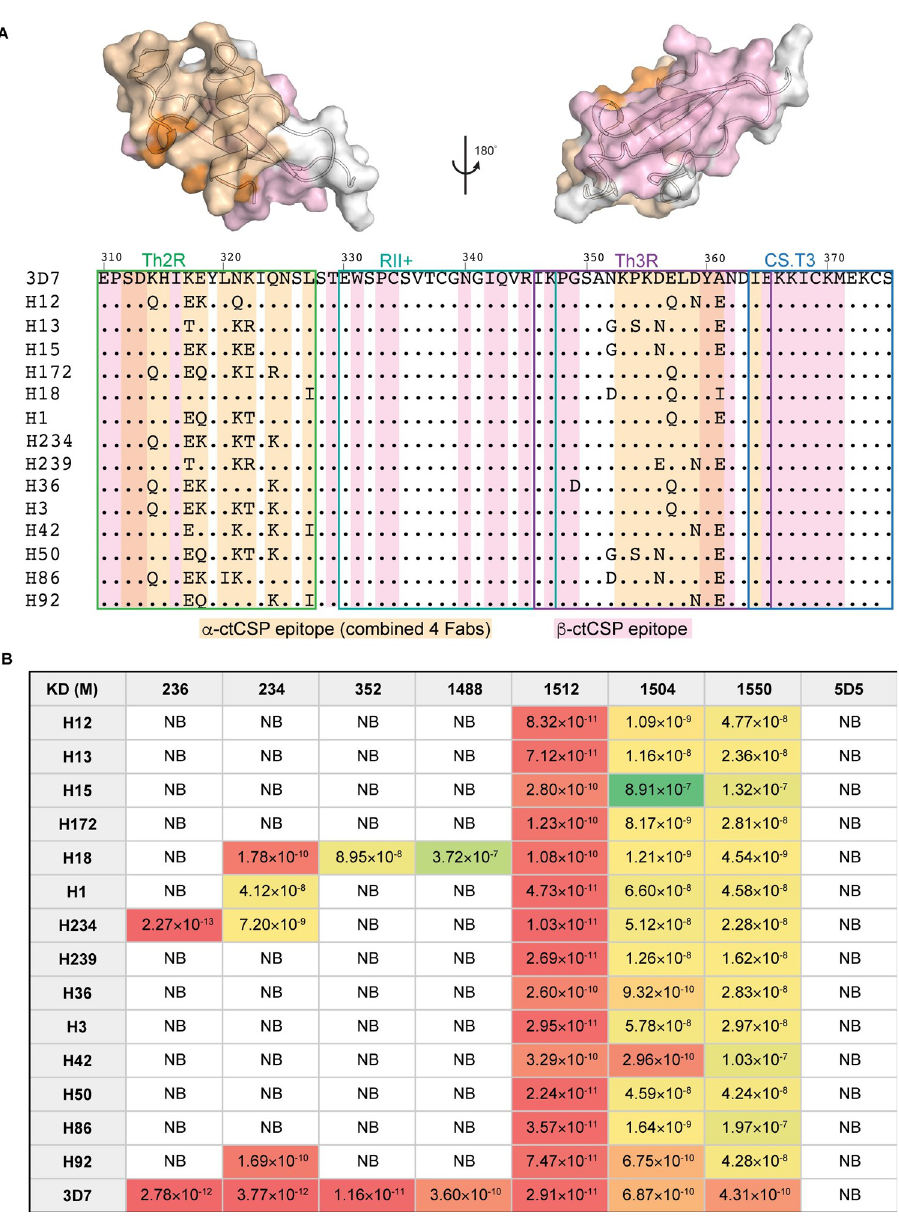
Fig 3. Sequences of α TSR in different haplotypes of P . falciparum and binding of mAbs to peptides corresponding to different haplotypes. A panel of ctCSP peptides were generated for mAb affinity measurements. ( A ) All ctCSP haplotypes that represent strains found across East and West Africa (31) were referenced against the C-terminal domain of PfCSP isolate 3D7. The Th2R, RII+, Th3R, and CS.T3 regions are enclosed in green, cyan, magenta, and blue boxes respectively. The combined α -ctCSP epitopes from mAbs 234, 236, 352, and 1488 are highlighted in wheat, whereas the β -ctCSP epitope of mAb 1512 is shown in pink. Residues that are present in both the α -ctCSP and β -ctCSP epitopes are highlighted in orange. The transparent surfaces overlaid with ribbons of ctCSP are also shown and the combined α -ctCSP epitopes, β -ctCSP epitope, and overlapping epitopes are colored in pink, wheat, and orange as above. ( B ) Dissociation constant (K D ) of all mAbs was measured against all generated ctCSP peptides using surface plasmon resonance (SPR). The strongest to weakest affinities are represented as a gradient from red to yellow and green, respectively. Boxes labeled with NB (no binding) represent haplotypes that had binding responses less than the negative control (humanized mAb 5D5, a Pf CSP N-terminus specific